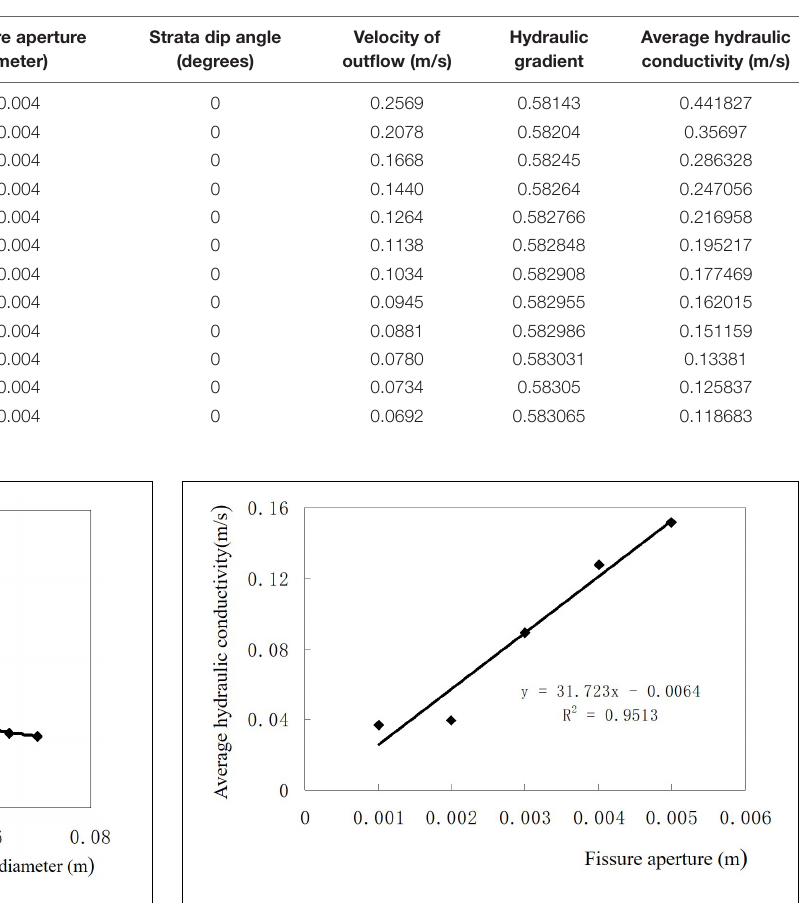
TABLE 6 | The simulation results while varying conduit diameter.